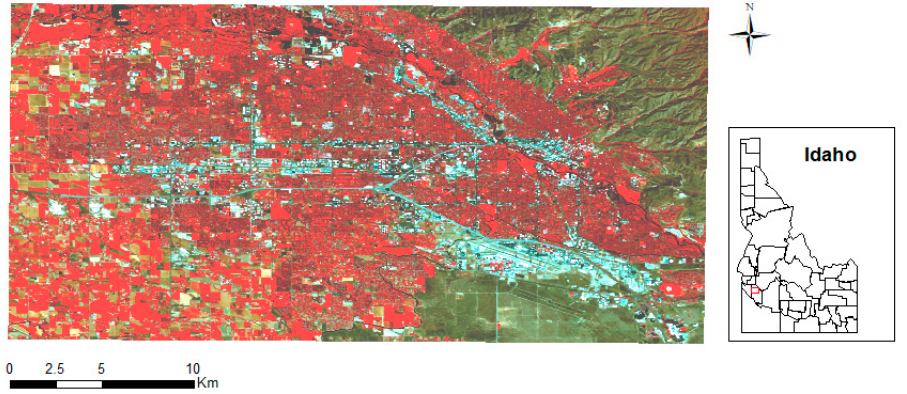
Figure 1. Landsat Thematic Mapper (TM) imagery of the study area located in the Boise-Meridian metropolitan region, Idaho. The image is displayed in a false color composite.